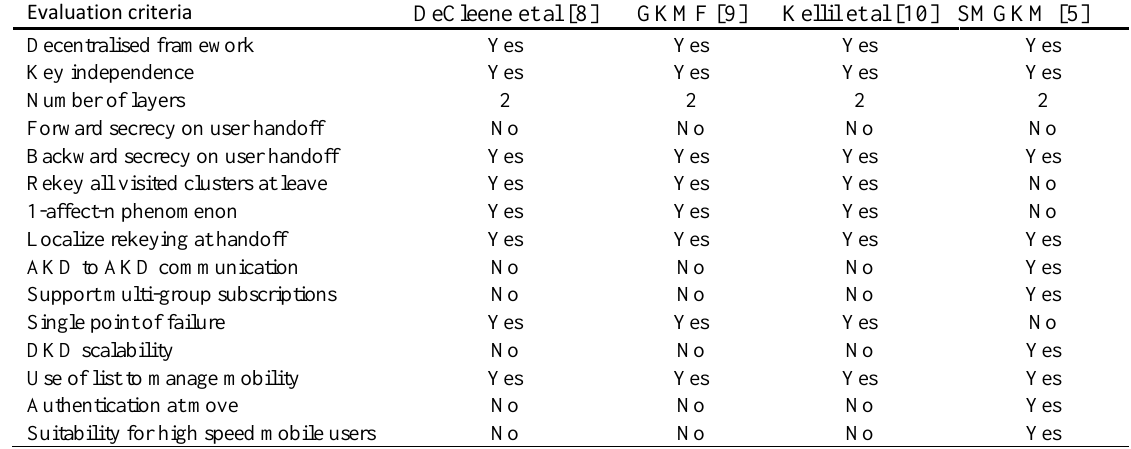
Table 1. Comparison of SMGKM characteristics against Key-Request schemes for a high mobility situation Evaluation